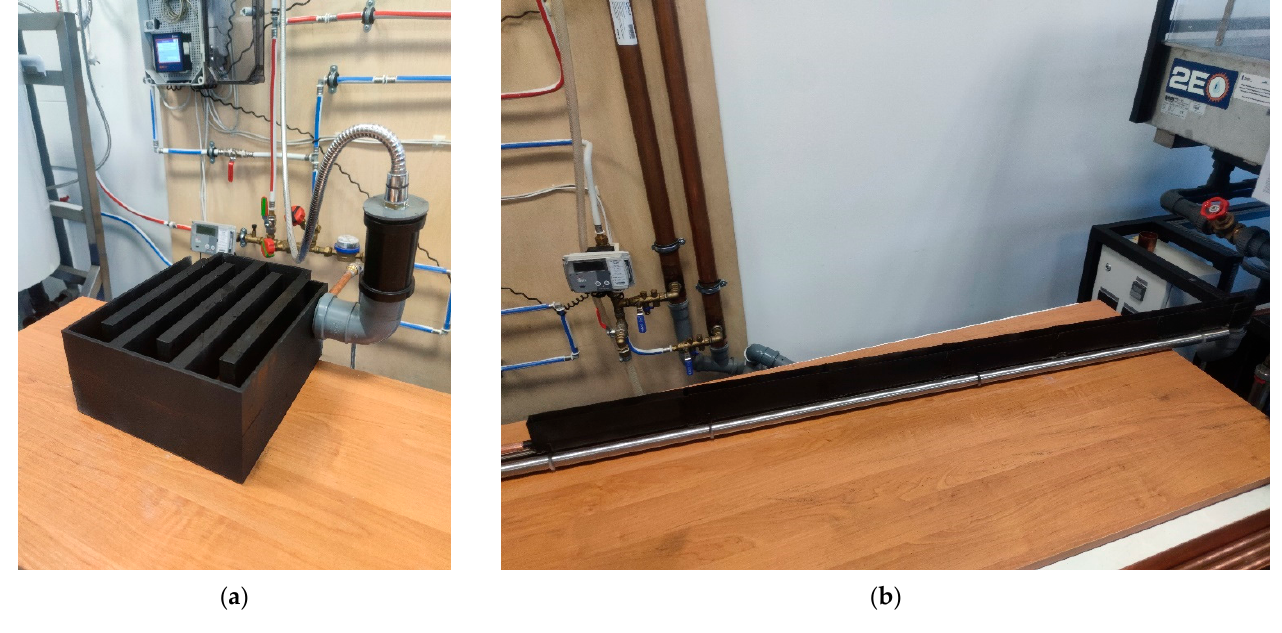
Figure 1. Tested shower heat exchangers: ( a ) compact DWHR unit; ( b ) linear DWHR unit.